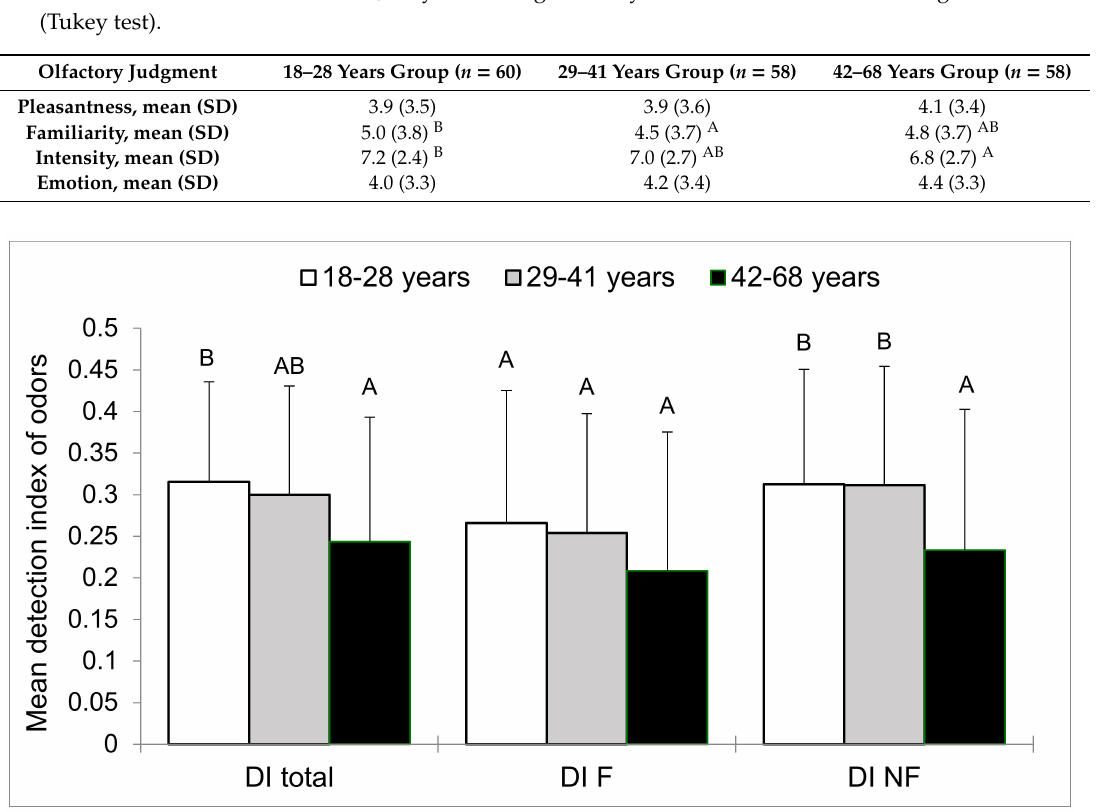
Figure 6. Between-age groups comparison of mean detection indices of odors (all odors: DI total; only familiar odors: DI F and only unfamiliar odors: DI NF). For each mean detection index of odors (all, familiar, or unfamiliar), values with the same letters are not significantly di ff erent at the 5% level of significance (Tukey test). Vertical bars indicate the standard deviation of the